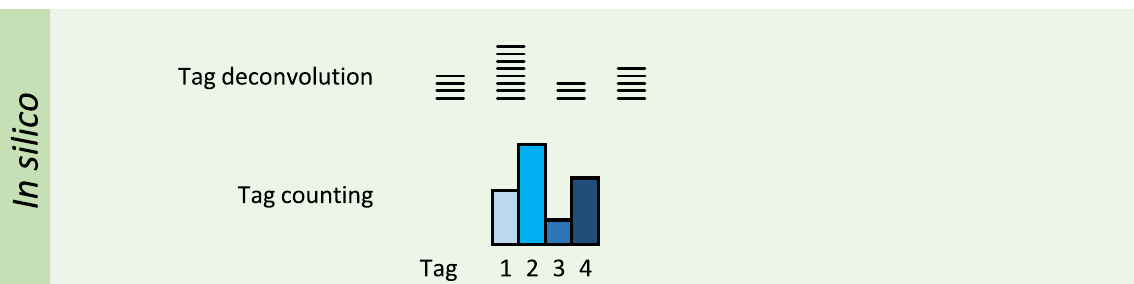
Fig 2. Summaryof SAGE. Within the organisms,genes are transcribed and spliced(in eukaryotes) to producemature mRNA transcripts (red). The mRNA is extracted from the organism, and reverse transcriptase is used to copy the mRNA into stable double-stranded–cDNA (ds-cDNA; blue). In SAGE, the ds-cDNA is digestedby restriction enzymes (at location “X” and “X”+11) to produce11-nucleotide “tag” fragments. These tags are concatenated and sequencedusing long-readSanger sequencing (different shades of blue indicate tags from different genes). The sequencesare deconvoluted to find the frequency of each tag. The tag frequencycan be used to report on transcriptionof the gene that the tag came from.